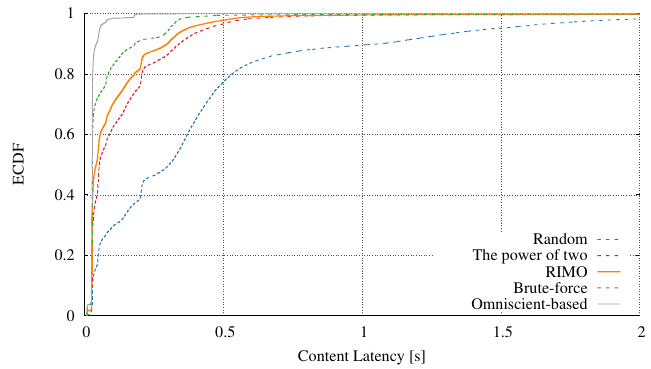
Figure 4. Client perception of the selected gateway’s performance.